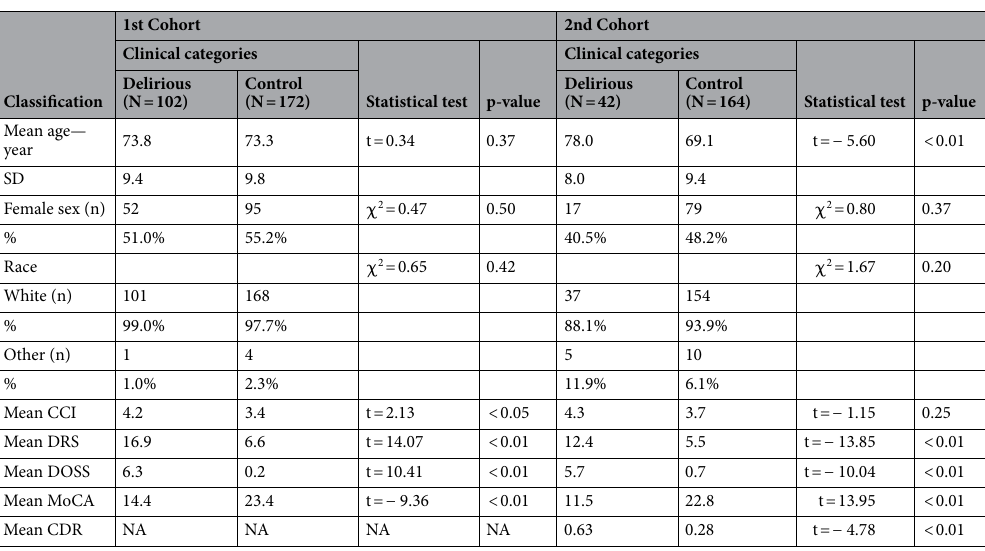
Table 1. Patient characteristics. CCI Charlson commobidity index, DRS delirium rating scale-revised-98, DOSS Delirium observation screening scale, MoCA Montreal Cognitive assessment, CDR clinical dementia